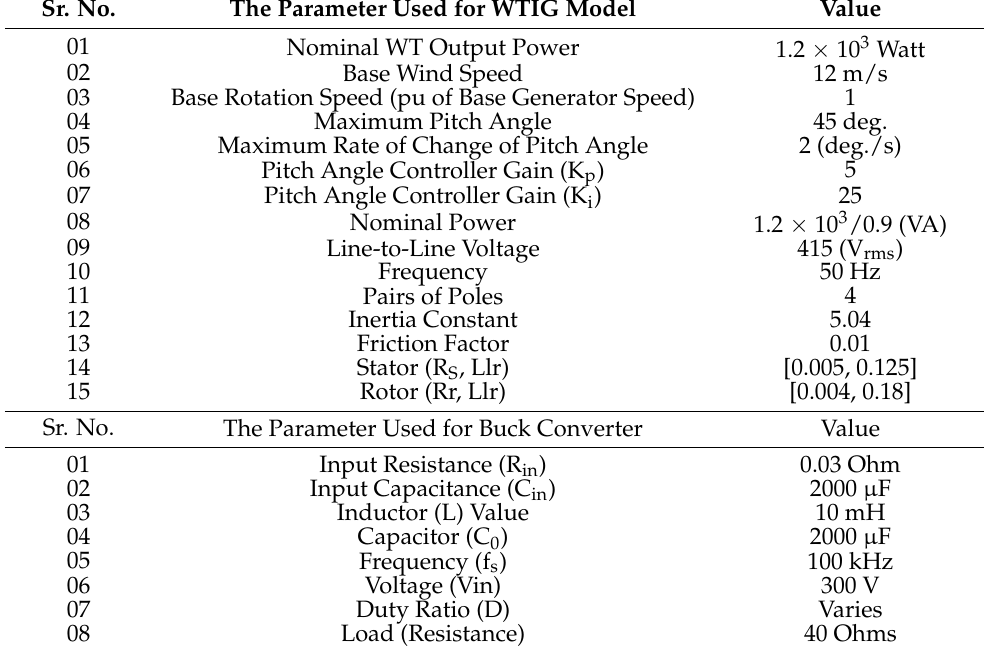
Table 4. Specifications of WT system. Sr.